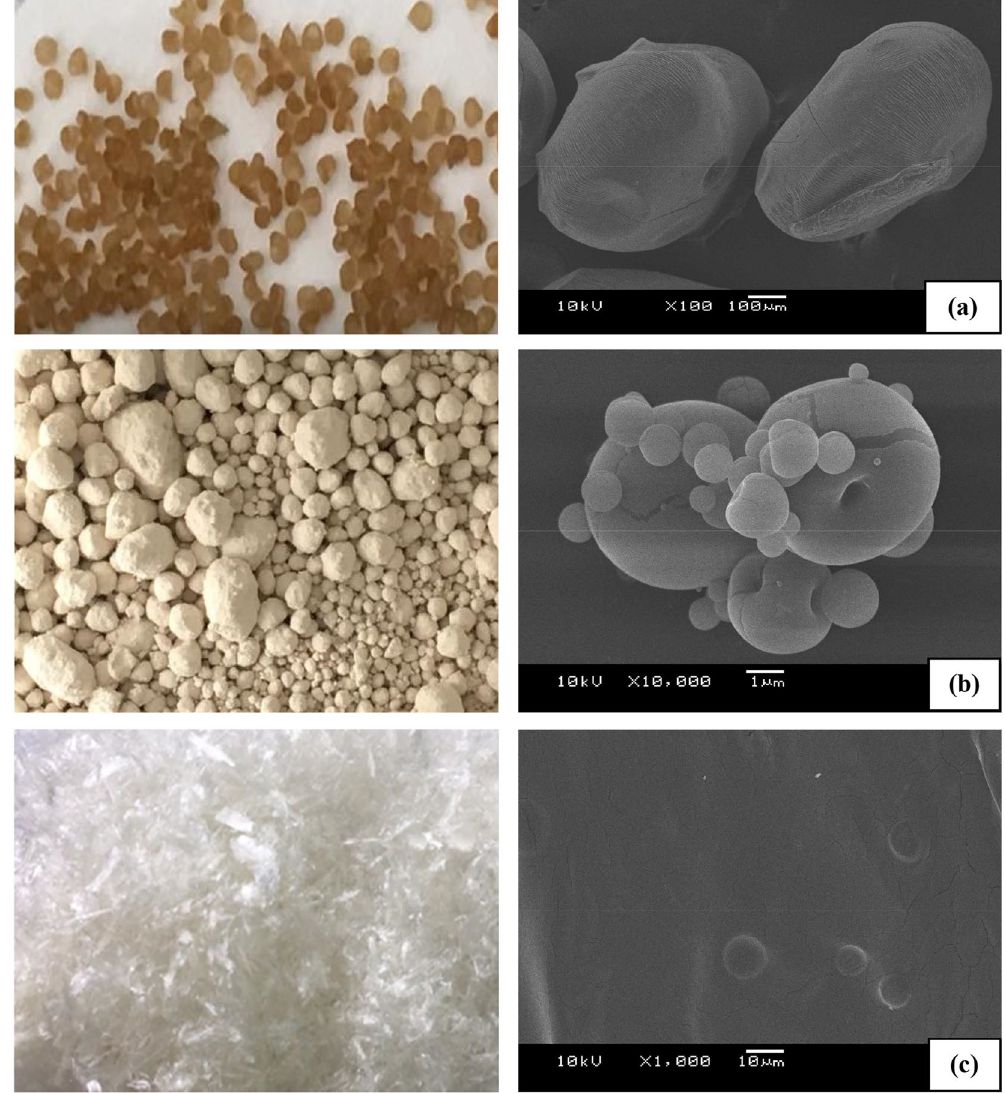
Figure 3. Representative physical and SEM images of the encapsulated capsules; showing the: ( a ) extruded capsule at 100x magnification, ( b ) spray-dried capsule at 10,000x magnification and ( c ) freeze dried capsule at 1,000x magnification. Images shown are representative of those seen from at least 3 such fields of view per sample and 3 samples.